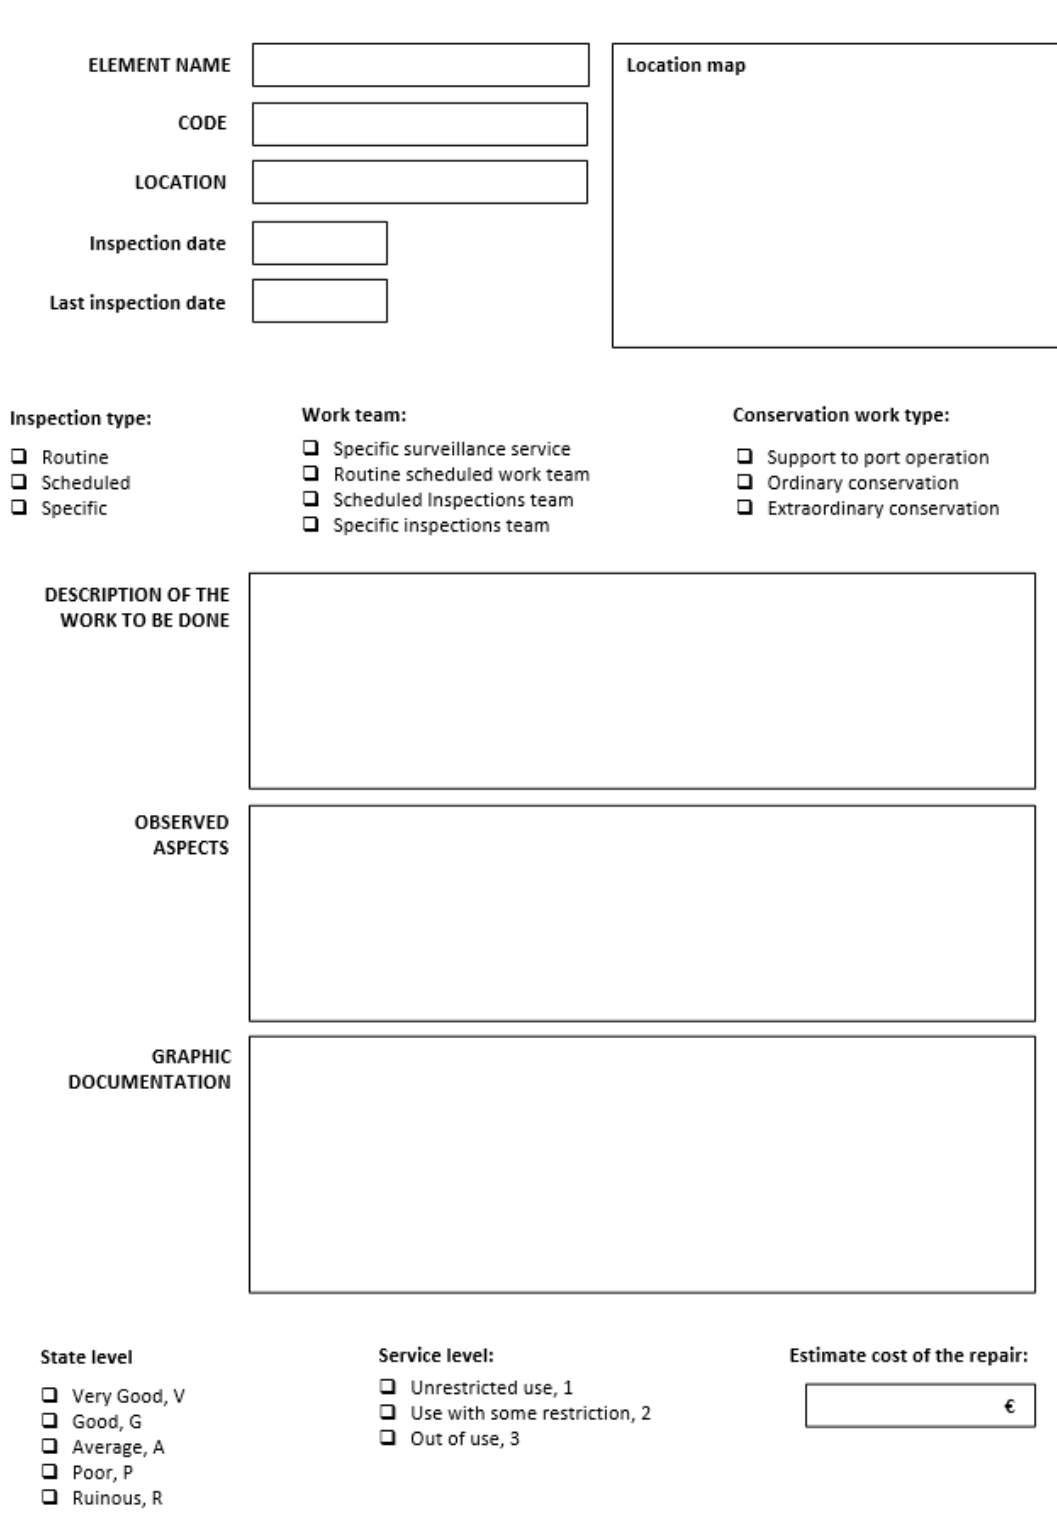
Figure 3. Inspection file.